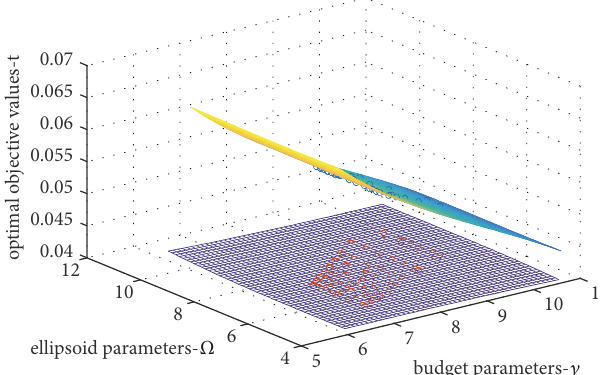
Figure 9: The comparison of optimal values of nominal model and distributionally robust model in Case II